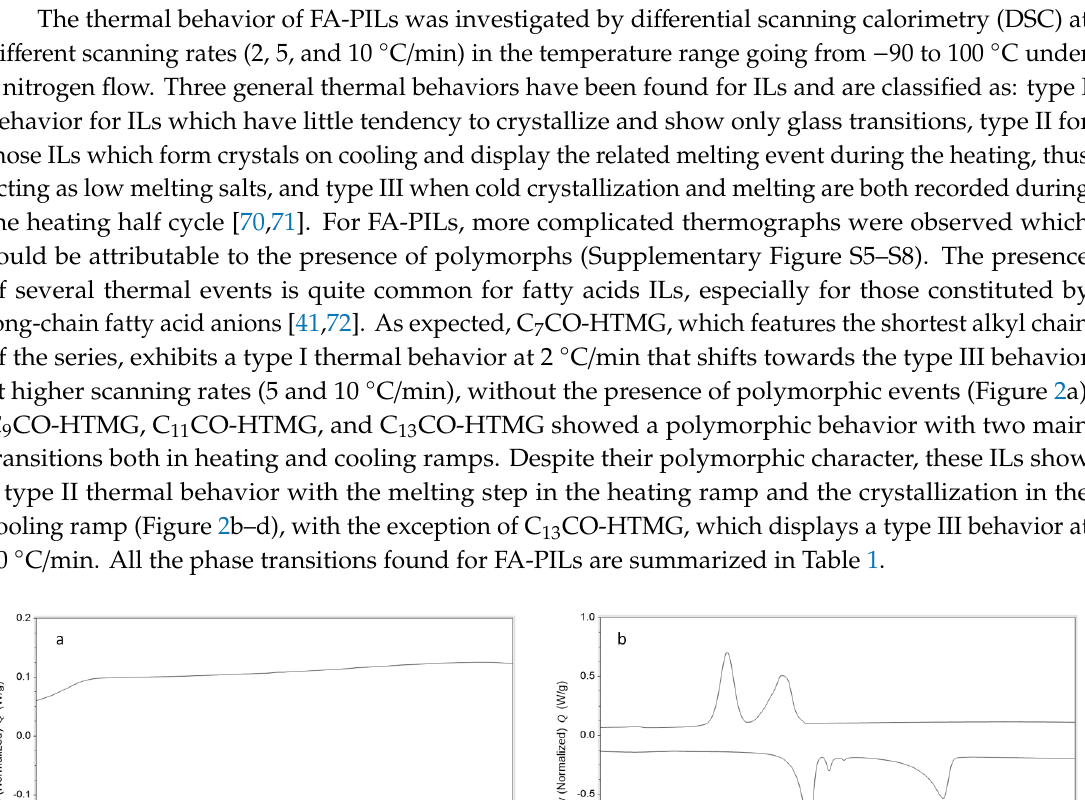
7 CO-HTMG ( a ), C 9 CO-HTMG ( b ), C 11 CO-HTMG